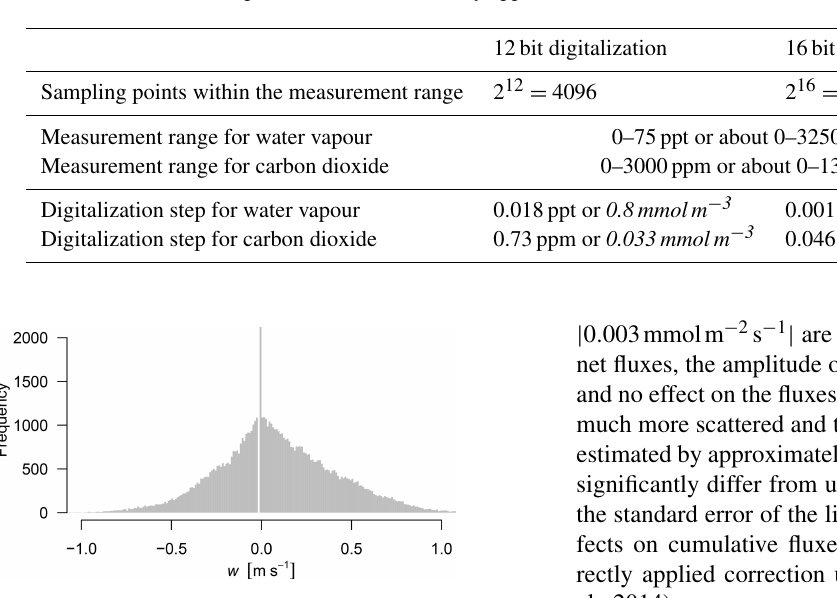
Figure 2. Quadrant (hole) analysis of all data points (20Hz sampling rate) of the vertical wind velocity and the carbon dioxide concentration for 1h (summer at noon) with 16bit digitalization (a) and reduced to 12bit digitalization (b) . A normalized density distribution in form of isopleths is included in both figures. Table 1. Characteristic resolutions for water vapour and carbon dioxide concentrations with 12bit and 16bit digitalization. Data in italics were used for the calculation. Parts per thousand is denoted by “ppt”.